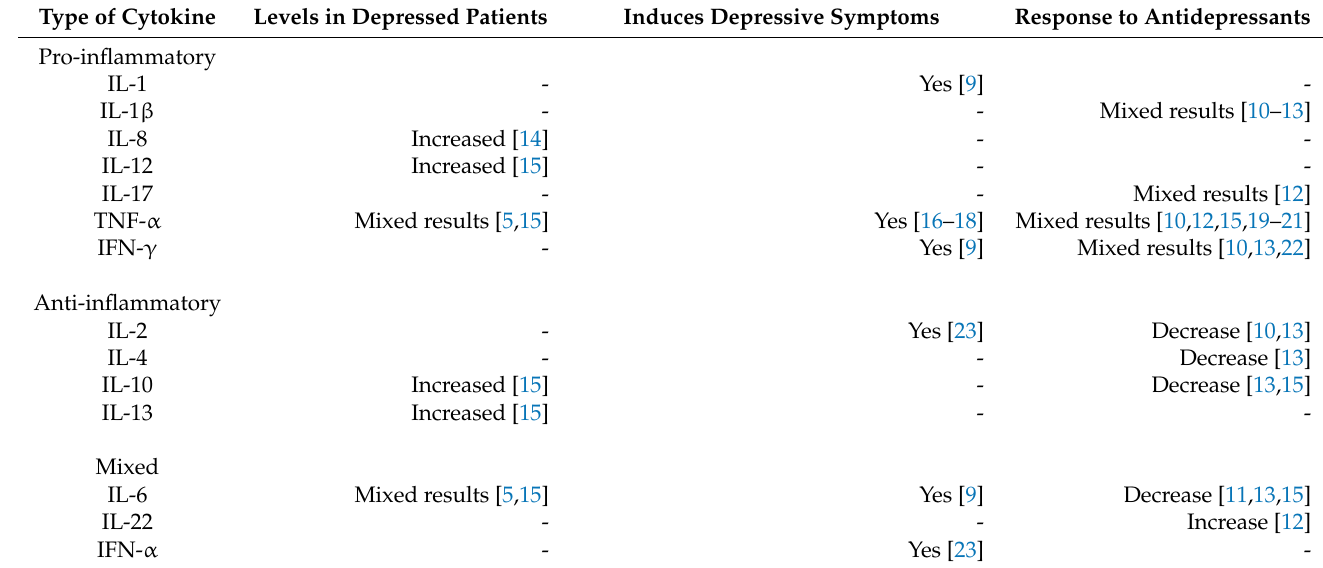
Table 1. Classification of cytokines and their roles in